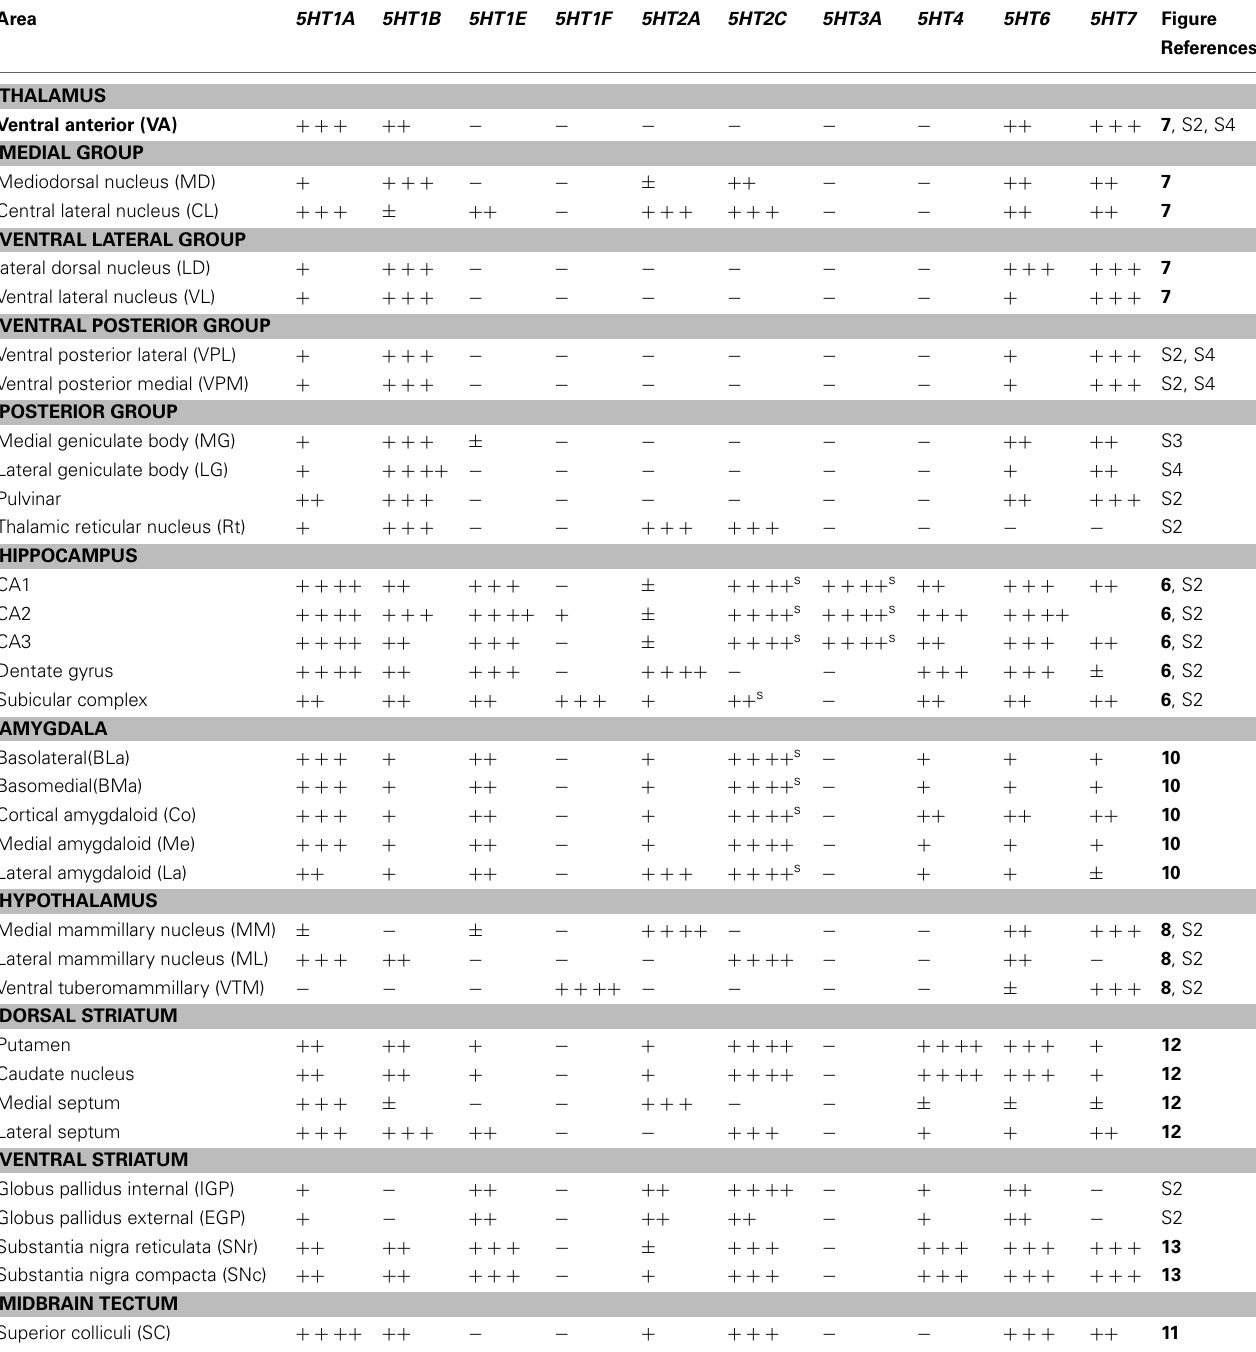
Table 3 | Arbitrary values assigned for different levels of expression in subcortical brain